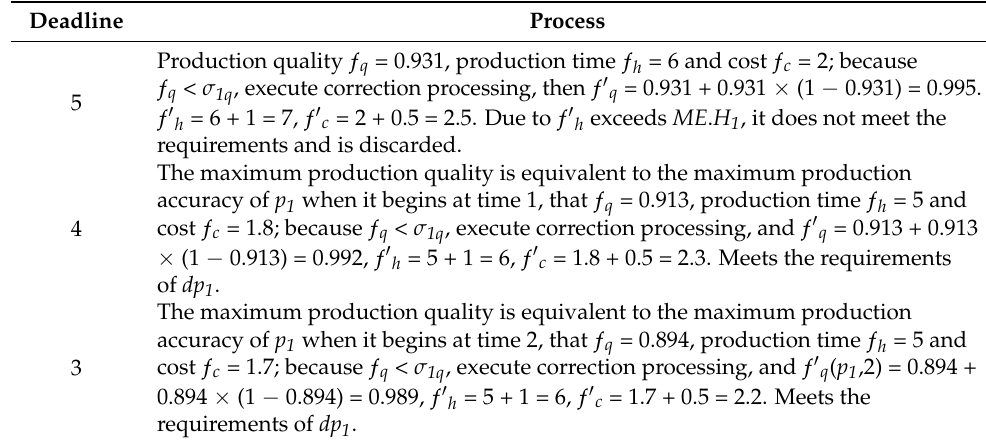
Table 3. Scheduling process and results of p (cid:48) [1–3] under different